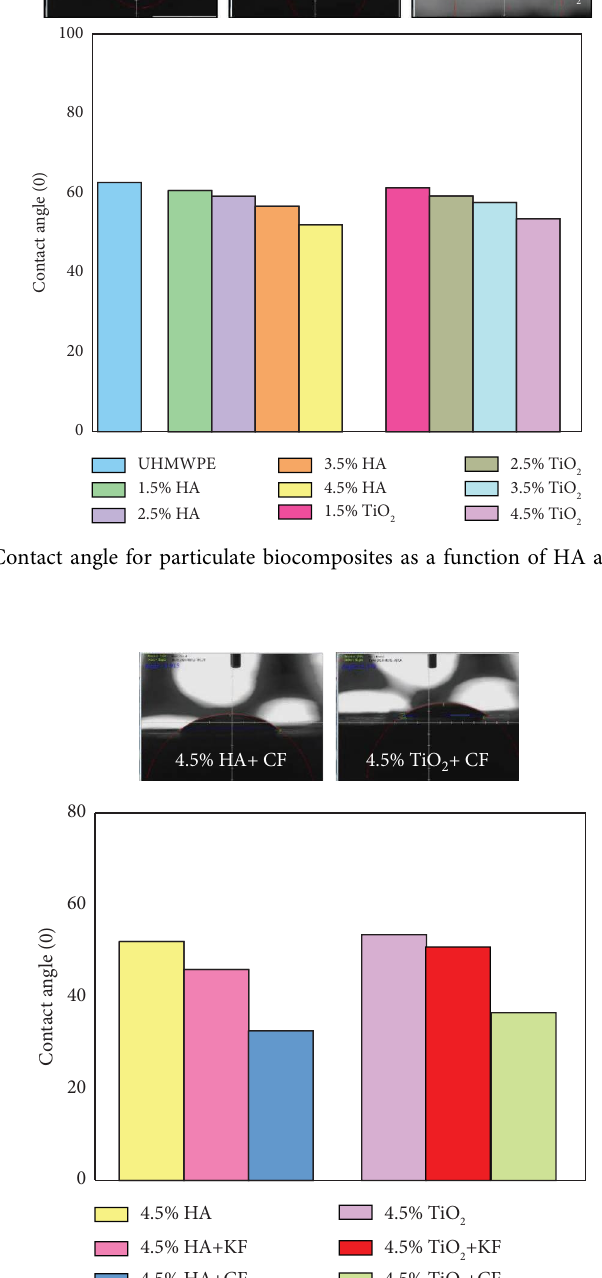
Figure 4: Contact angle for hybrid biocomposites as a function of types of